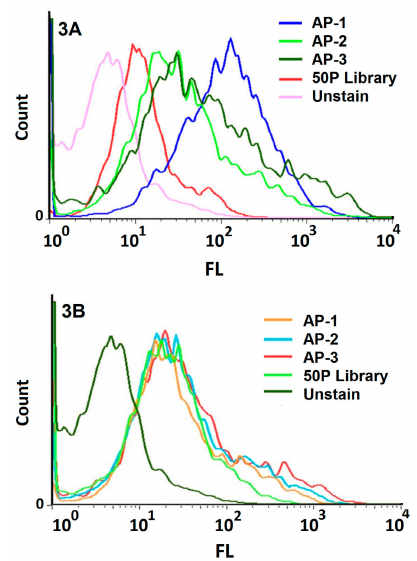
Figure 3. The evaluation of binding affinity of three selected aptamers of pool 10. ( 3A ) the binding affinity of AP-1, AP-2 and AP-3 aptamers to CD20 + HEK293T cells and ( 3B ) of all three aptamers incubated with the HEK293T cells under the same